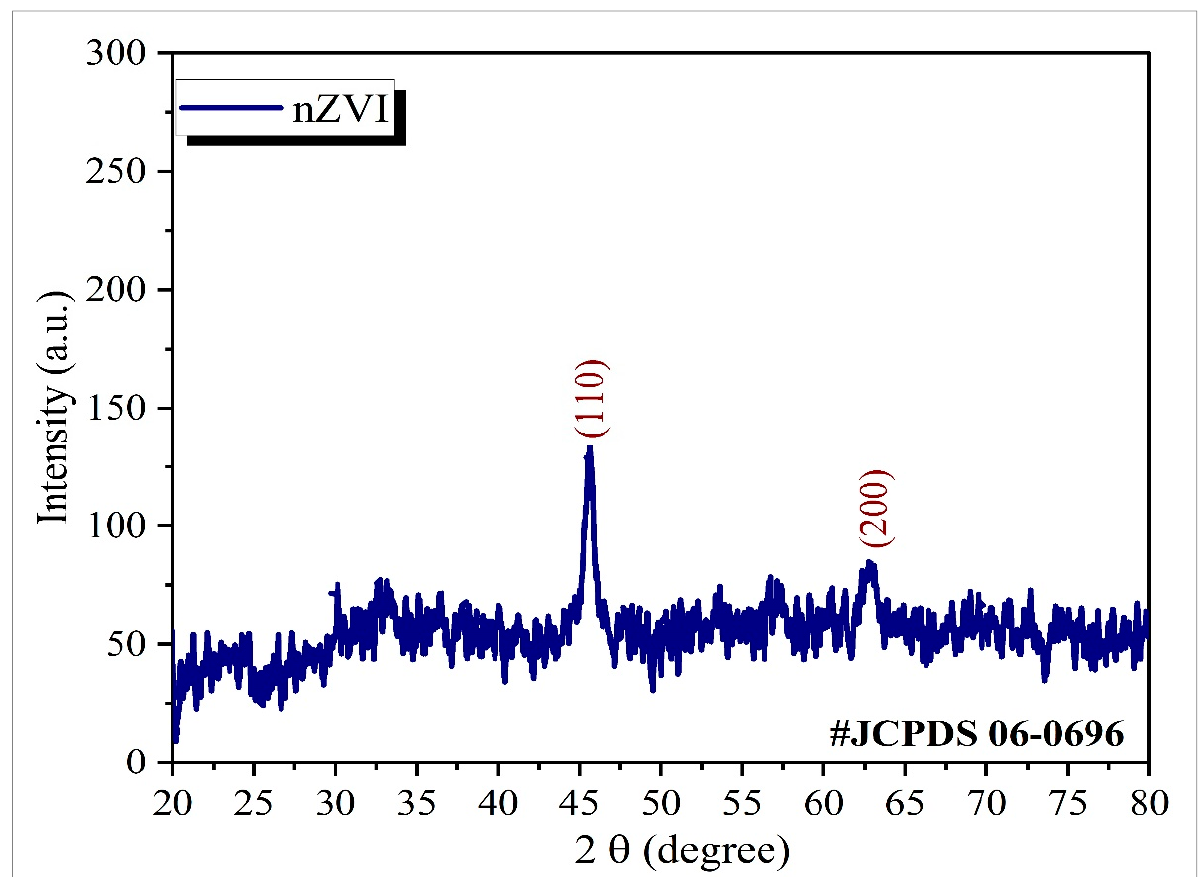
Figure 2. XRD spectra of synthesized nZVI particles.